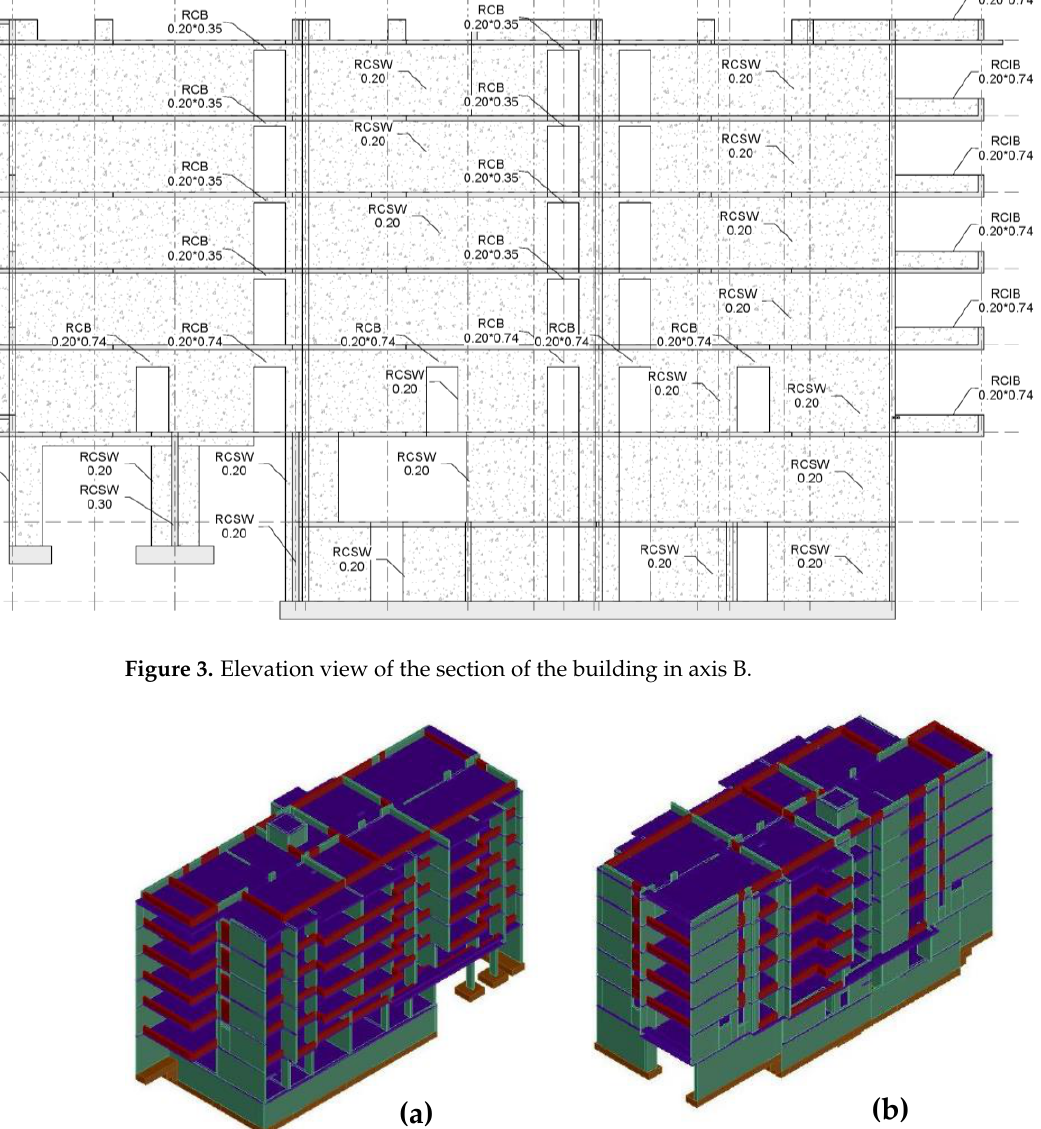
Figure 4. Axonometric perspective ( a ) Northeast and ( b ) southeast.